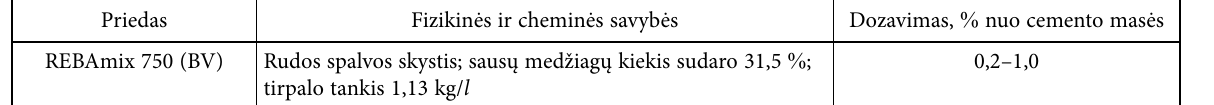
Table 1. Technical information on REBAmix 750 (BV) plasticizer Priedas Fizikinės ir cheminės savybės Dozavimas, (cid:8) nuo cemento masės REBAmix 750 (BV) Rudos spalvos skystis; sausų medžiagų kiekis sudaro 31,5 (cid:8) ; tirpalo tankis 1,13 kg/